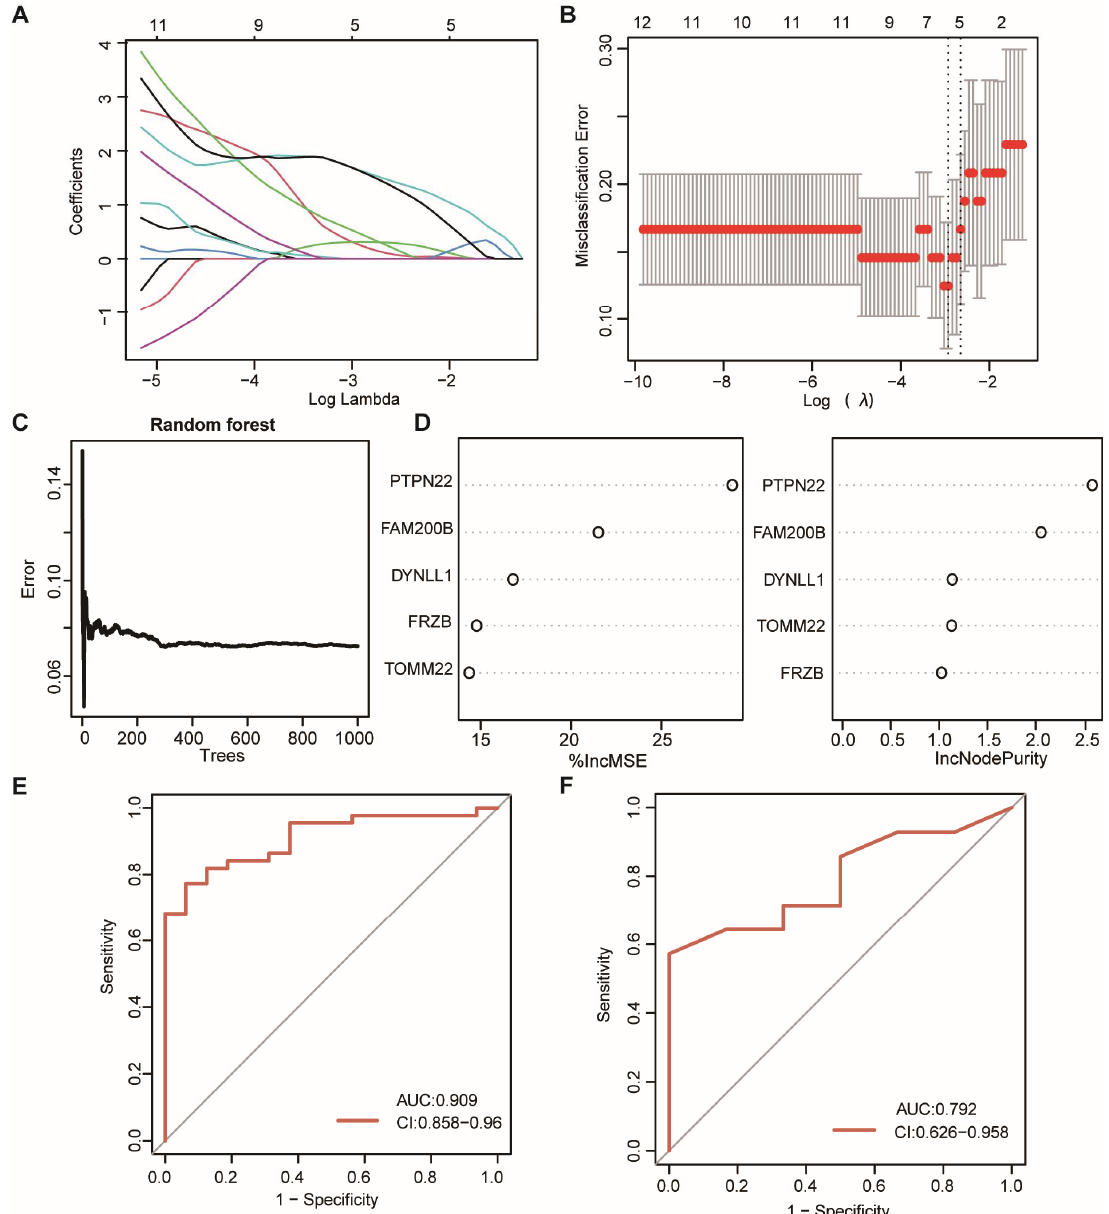
Figure 5. Construction of the predictive model for OSA. ( A ) LASSO coefficient profiles of OSA- specific genes. ( B ) 10-fold cross-validation for tuning parameter selection in the LASSO regression. ( C ) Correlations between the related errors and the number of decision trees. ( D ) The scatter plot of the RF variables based on the percentage of increase of mean square error (%IncMSE) ( left ) and the percentage of increase in node purity (%IncNodePurity) ( right ), respectively. ( E , F ) The prediction efficacy of RF model was evaluated by the ROC curve and AUC value based on the training set ( E ) and validation set ( F ).